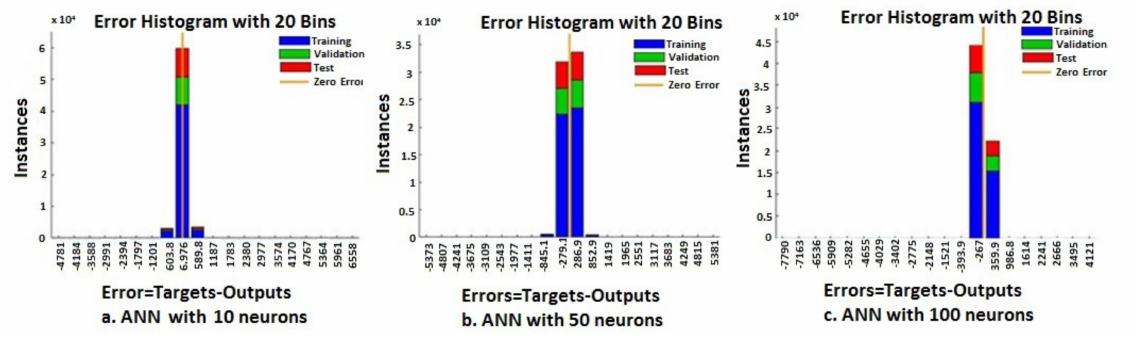
Figure 13. Error histograms—ANN with 10, 50, and 100 neurons.